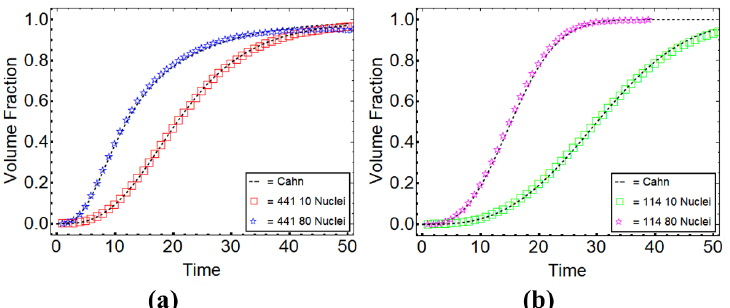
Figure 5. Transformation kinetics of oblate ellipsoids nucleated on 20 random parallel planes. The nucleation was site-saturated. That is, all nuclei started to grow at the time origin: t 0 = . The symbols correspond to the computer-simulated result, whereas the dashed line was calculated using Cahn’s model modified for ellipsoids. Each figure shows the effect of the number of nuclei per plane on the transformation kinetics: 10 nuclei and 80 nuclei on each plane. Figure 5a depicts the result of the number of nuclei per plane on the transformation kinetics of oblate ellipsoids. The ratio of the length of the longer axes to the length of the shorter axis of the oblate ellipsoid is 4:4:1. Figure 5b depicts the result of the number of nuclei per plane on the transformation kinetics of prolate ellipsoids. The ratio of the length of the shorter axes of the prolate ellipsoid to the longer axis is 1:1:4.